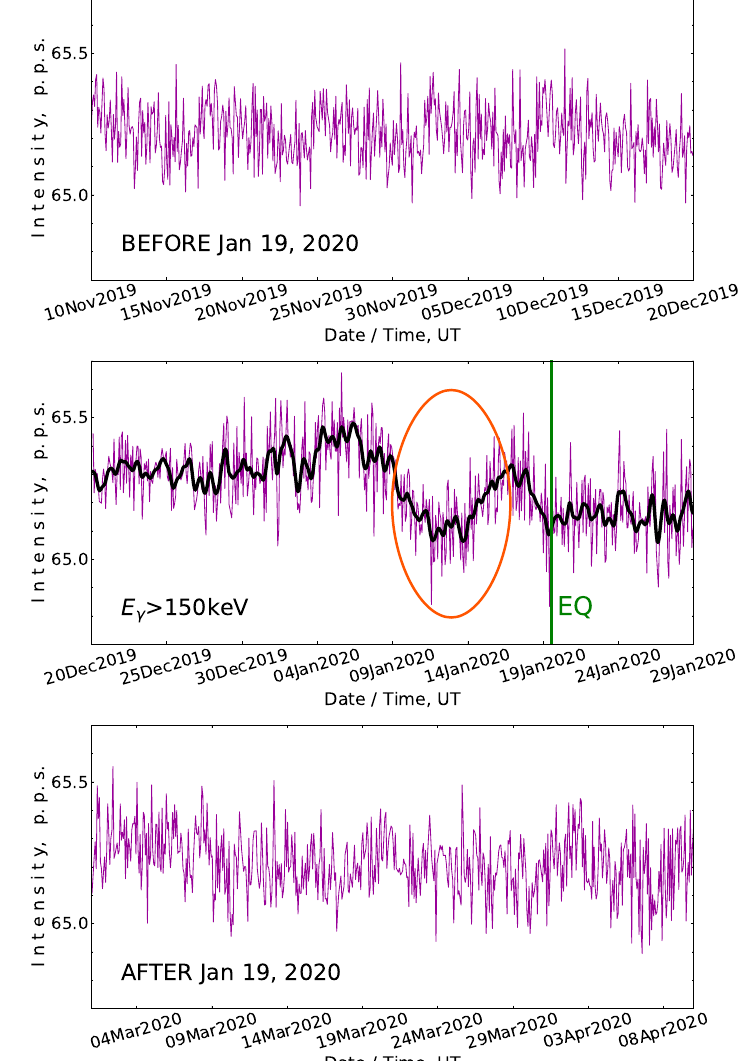
result of the additionally applied filtering is shown by the thick black curve in the middle panel only. Among the three plot frames in Figure 3, the upper one corresponds to the middle one overlaps this moment, and the data acquired much later than the earthquake are reproduced in the bottom plot. Each plot in the figure covers a prolonged time lapse of the order of a few weeks.